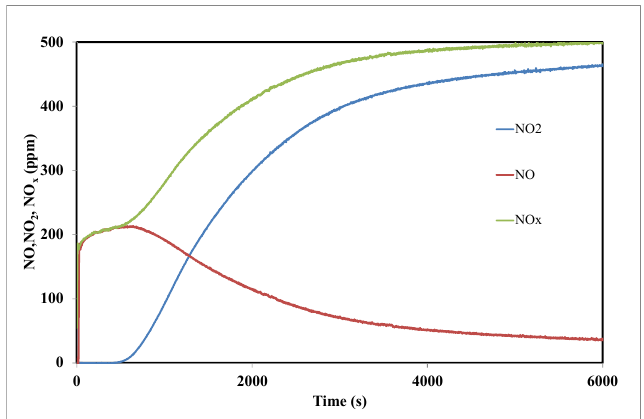
Figure 9. Outlet concentrations of NO 2 , NO and NO x during the adsorption of 500 ppm NO 2 at room temperature on the activated carbon A.